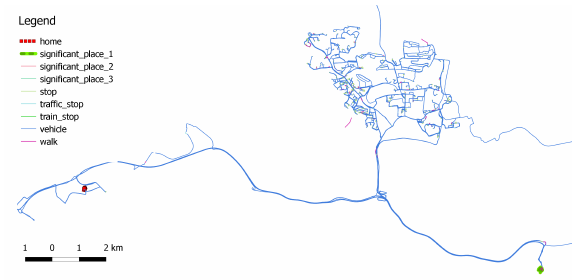
Figure 3: Classified GPS trajectory of an individual who carried a GPS tracker for a week.